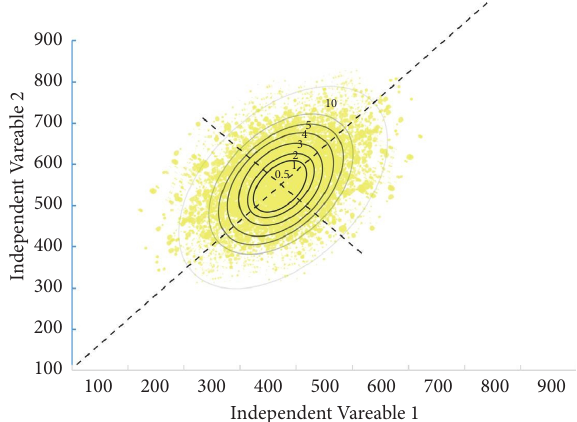
Figure 3: Mahalanobis distance